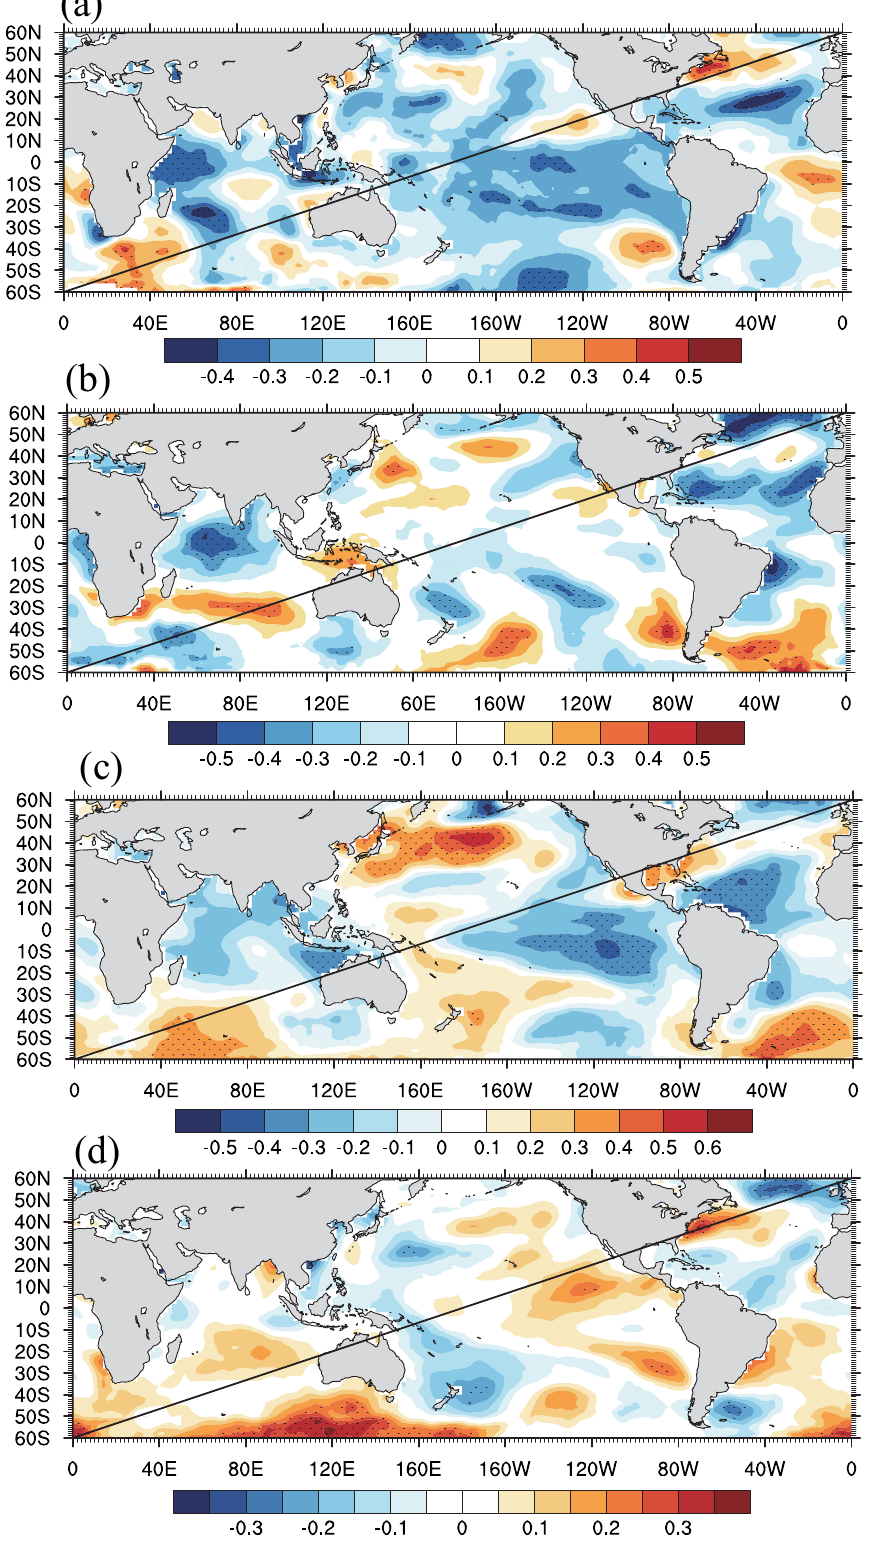
Figure 11. Spatial correlations between regional moisture and SSTs for the periods of ( a ) 1870–1900, ( b ) 1901– 1930, ( c ) 1931–1960, and ( d ) 1961–2014. Dots indicate the correlation coefficients over the 90% confidence level. Figures are created using NCL version